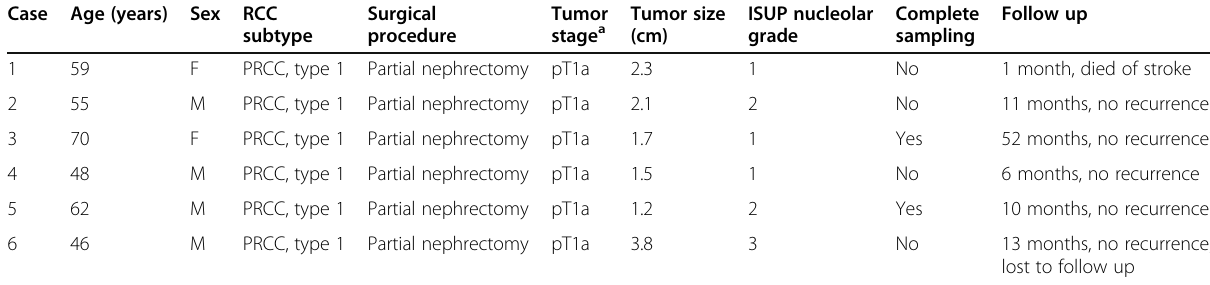
Table 2 Summary of clinicopathologic features of cases with tumor seeding along the biopsy needle tract Case Age (years) Sex RCC